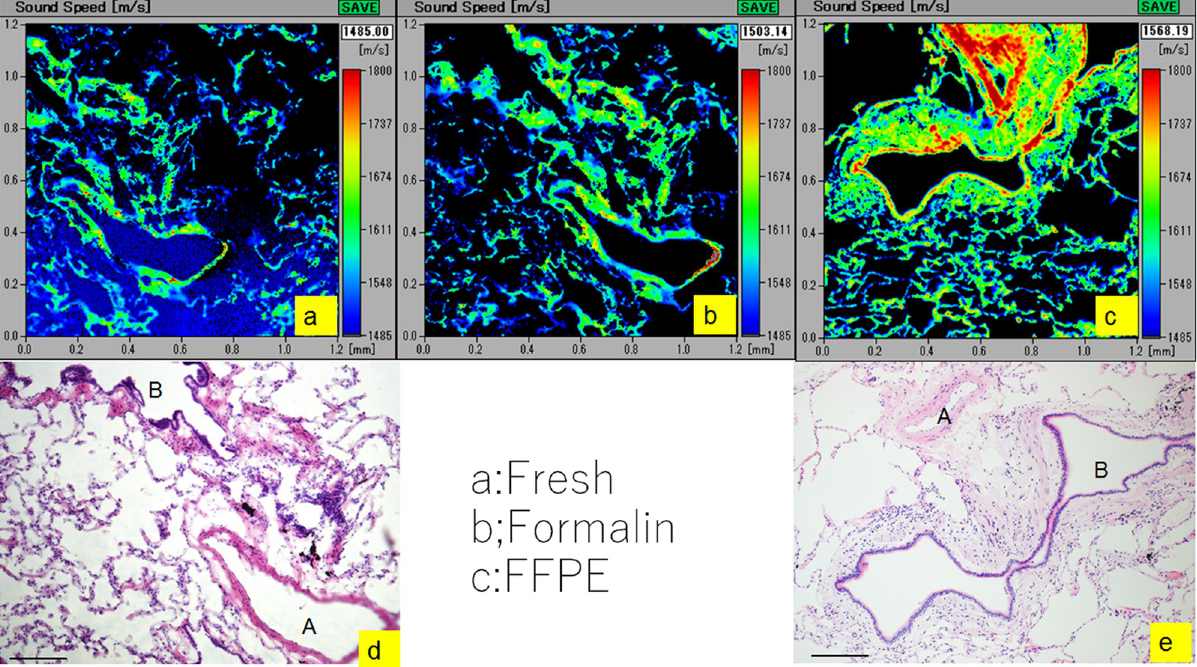
Fig 1. Differences in SOS valuesamong fresh-frozen, formalin-fixed, and FFPE sections. Comparison of SOS images of unfixed, fresh-frozen ( a ), formalin-fixed ( b ), and FFPE ( c ) sections. The corresponding light microscopic images of sections stained with hematoxylin and eosin ( d, e ). All images include bronchioles (B), arterioles (A), and alveoli. SOS values are represented by color indicators present on the right side of each image. The fresh- frozen section exhibits the lowest SOS values in bronchioles and arterioles, the formalin-fixed section displays intermediate SOS values, and the FFPE section exhibits the highest values. In alveoli, SOS values gradually increase from the fresh-frozen section to the formalin-fixed and FFPE sections. The blurred outline in the bronchiolar and alveolar walls has become clearer after fixation. Scale bar = 200 μ m.